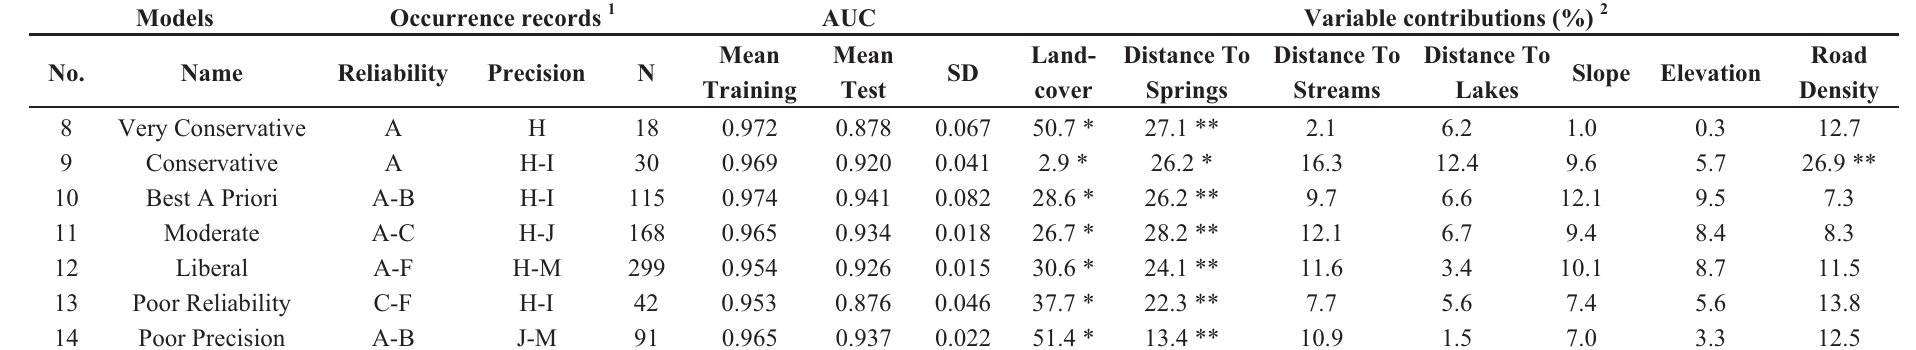
Table 4. Occurrence records, area-under-the-curve (AUC) statistics, and variable contributions to biophysical ecological niche models for the white-nosed coati ( Nasua narica ) in Arizona and New